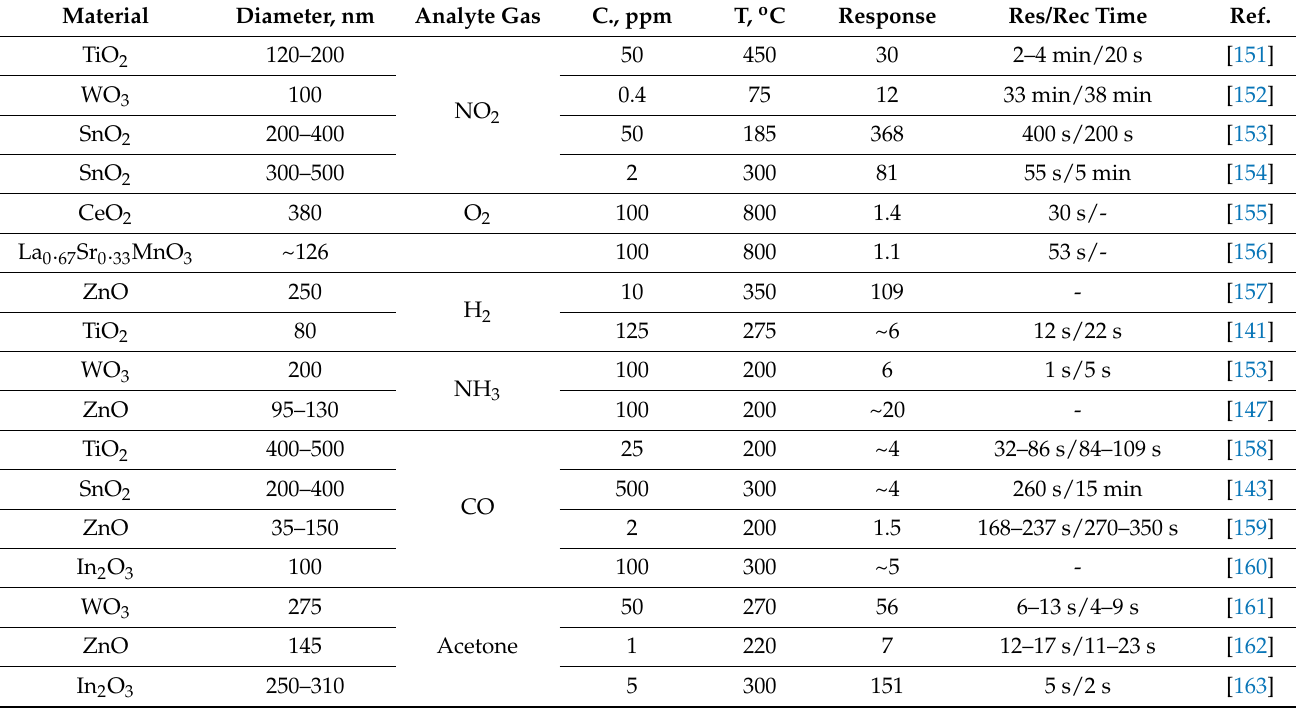
Figure 8. ( a ) Response–temperature curves of the four kinds of electrospun WO 3 -based sensors to 3 ppm NO 2 at various temperatures; ( b ) the corresponding response and recovery times of all sensors to NO 2 listed in Table 2. T oper = 90 ◦ C. Reprinted with permission from [139]. Copyright 2021 Elsevier. Table 1. Metal oxide nanofiber-based conductometric gas sensors and their